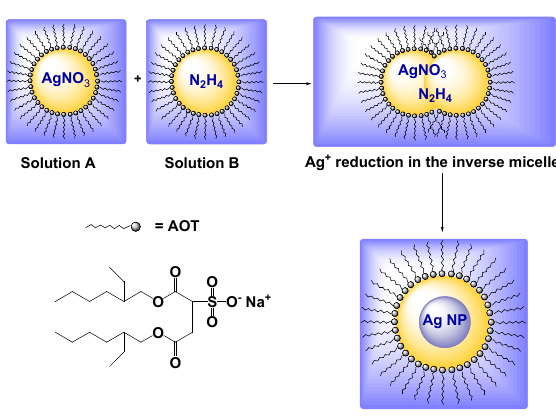
Figure 7. Synthesis of silver nanoparticles using AOT inverse micelles formed in a dodecane/water mixture.